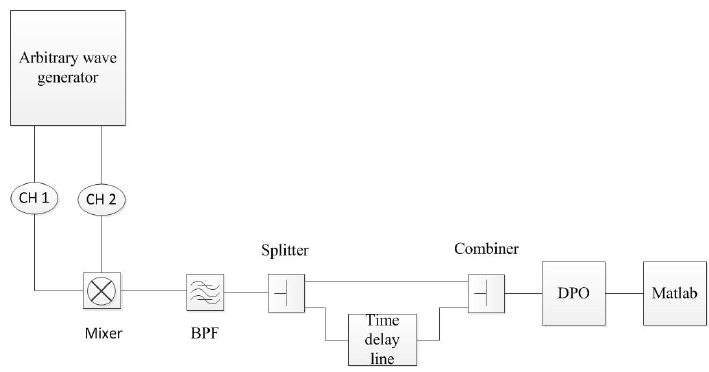
Figure 9. Experimental schematic diagram of the TDS M-C arrangement.